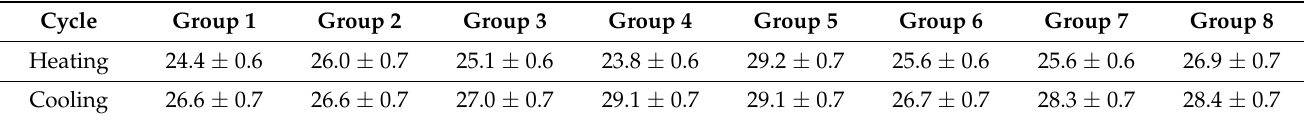
Table 5. (cid:104) C p (cid:105) , J/(mol × K) for heating and cooling cycles.